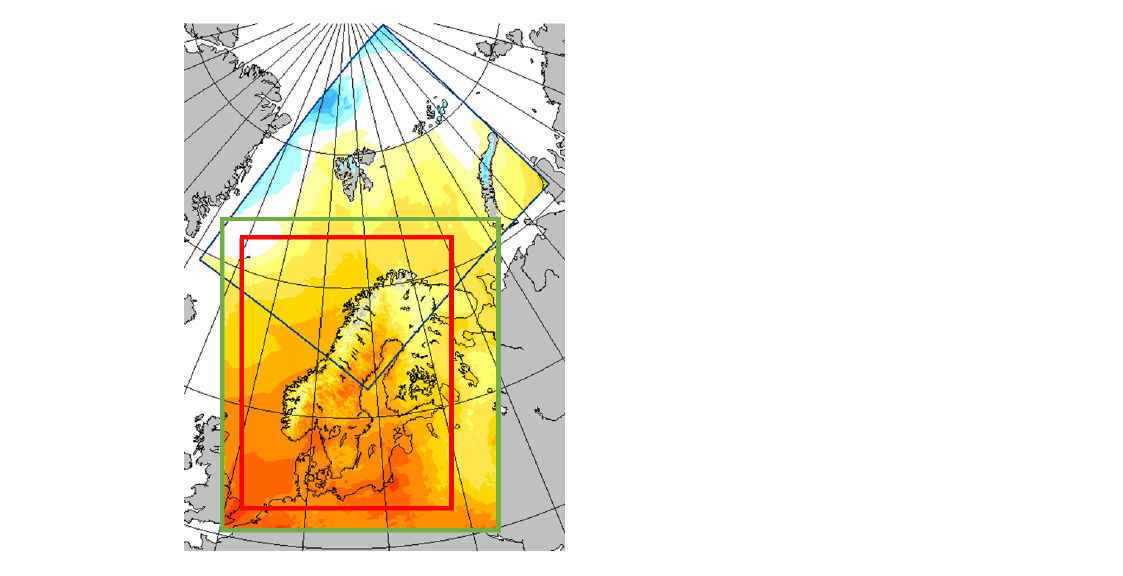
Figure 1. Coverage area for the NWP products. Blue square: Arome Arctic, green square: MEPS, red square: post-processed products (source: MET Norway).